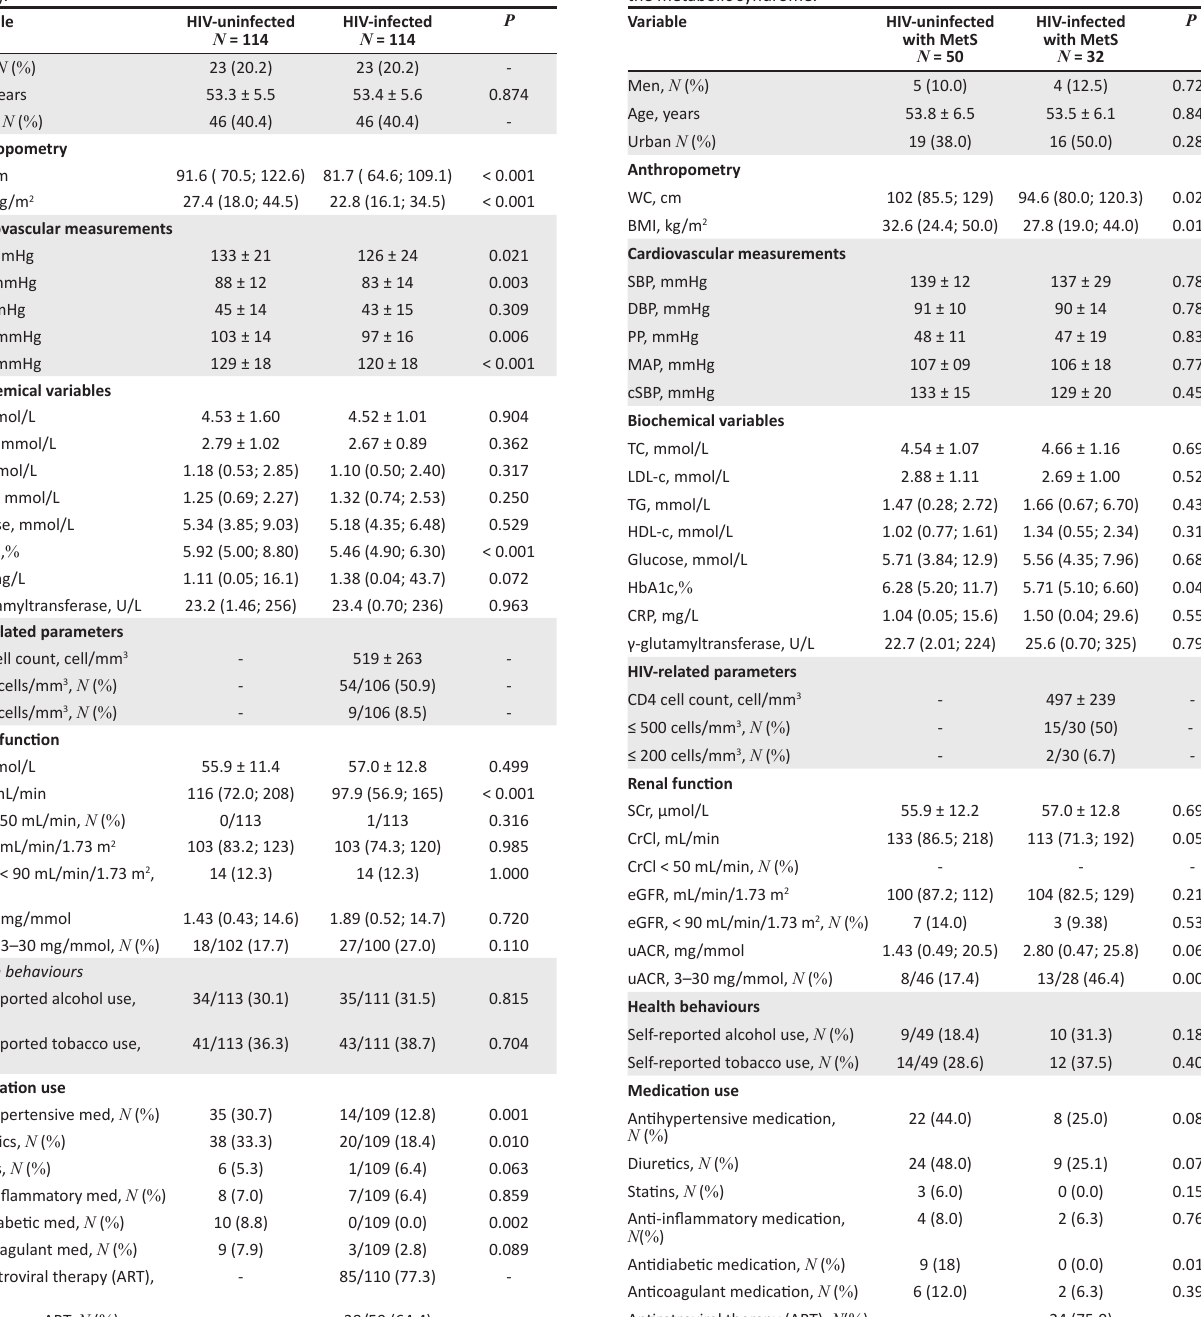
TABLE 2: Characteristics of the HIV-uninfected and HIV-infected individuals with the metabolic